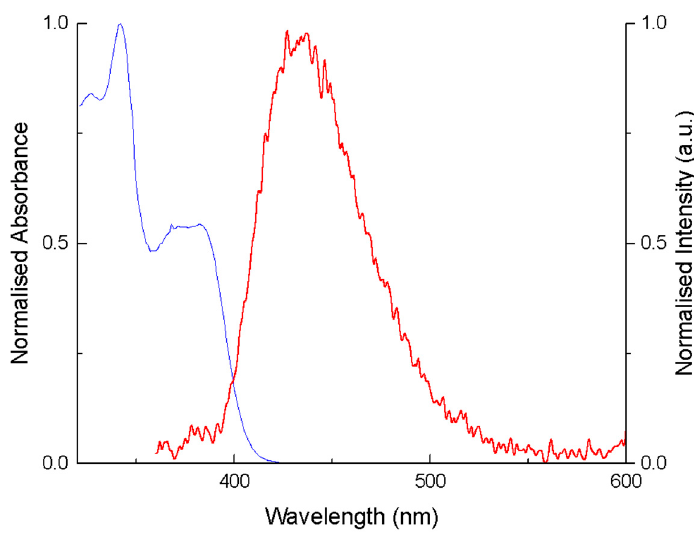
Figure 3. Normalised absorption and emission spectra of 6 in DMSO.